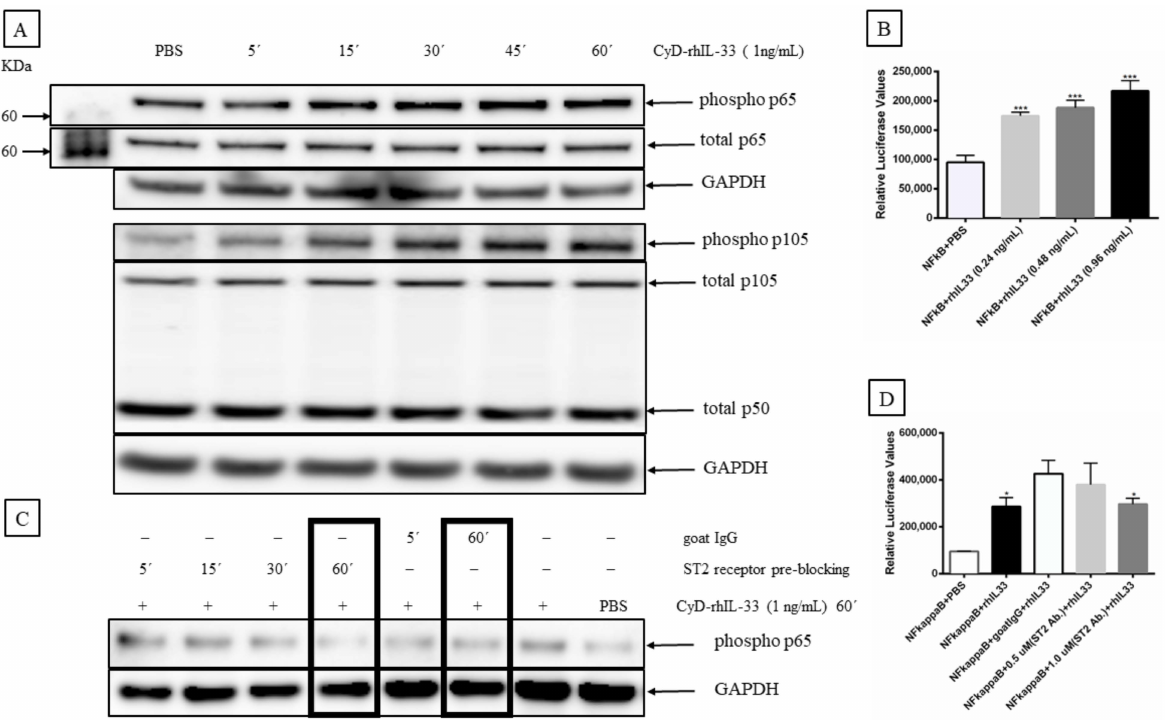
Figure 10. IL-33 upregulates NF- κ B activity. ( A ) NF- κ B activation was determined by monitoring phosphorylation of the subunit p65 and the p50 precursor p105. MCC-13 cells were serum starved for 24 h, and then stimulated with 1 ng/mL of CyD-rhIL-33 for varying times from 5–60 min. PBS was used as a vehicle control. Relative phospho-p65 and phospho-p105 levels were determined by western blot using phospho-specific antibodies. ( B ) The effect of rhIL-33 on NF- κ B-mediated promoter activity. NF- κ B activity was measured by using a luciferase reporter plasmid containing a minimal promoter (TATA box) and a NF- κ B-responsive element. Cells were stimulated with 0.24, 0.48, and 0.96 ng/mL of rhIL-33 for 4 h. Luciferase values were normalized to total protein. ( C ) The effect of ST2 receptor blocking on the IL-33-induced activation of NF- κ B. Phospho-p65 levels were determined by western blotting. MCC-13 was serum starved for 24 h, and then pre-blocked with goat anti-ST2 antibody (2 ng/mL) or normal goat IgG for a varying time duration (5–60 min). The cells were then stimulated with CyD-rhIL-33 (1 ng/mL) for 60 min. PBS was used as a control. ( D ) Anti-ST2 antibody ablates the IL-33-induced activation of NF- κ B. Cells were transfected with the presence of, or without, anti-ST2 antibody (0.5 or 1 µ g/mL) for 4 h. Goat IgG was used as a control. Each bar represents the average of three independent parallels. Luciferase values were corrected for protein concentration of the samples. * p ≤ 0.05, *** p ≤